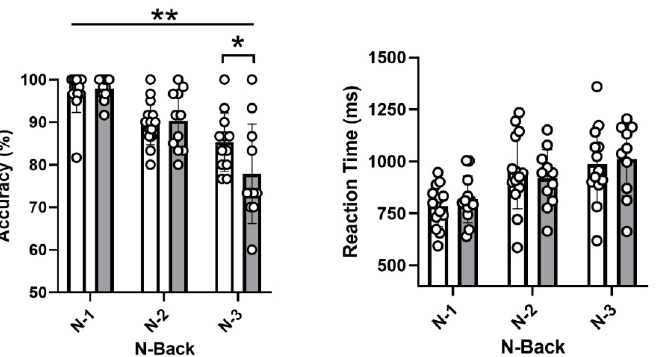
Figure 2. N-Back accuracy (left panel) and reaction time (right panel) in physically active pre- (white bar) and post- (grey bar) menopausal females . Data are presented as mean ± SD with individual values for 13 pre- and 10 post-menopausal females. The p value is for an ANCOVA with age as covariate. * p < 0.05; ** p <